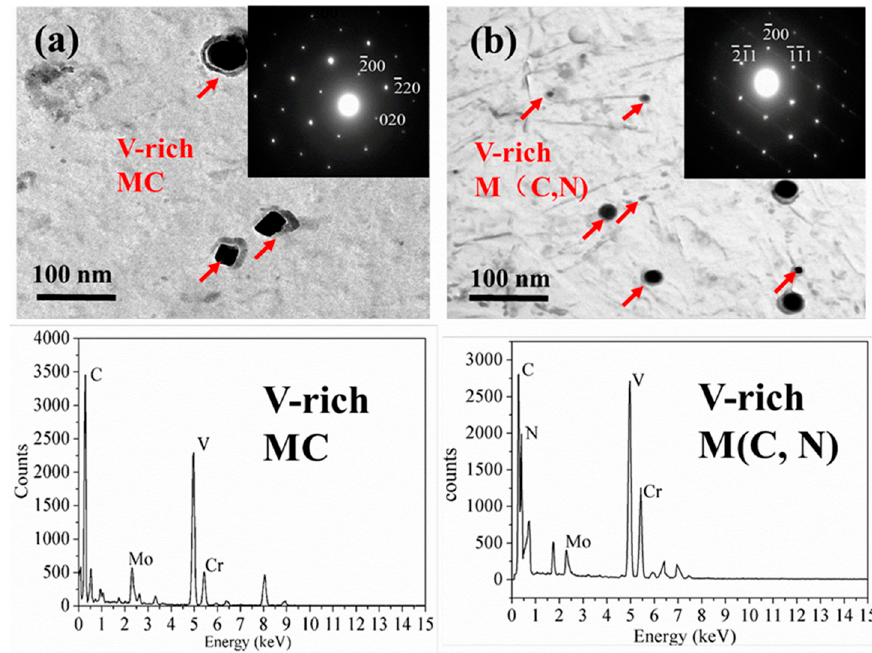
Figure 4. Transmission electron micrographs of the microstructure of the precipitates in samples at 1030 °C quenching temperature: ( a ) Nitrogen-free steel; ( b ) nitrogen-alloyed steel.